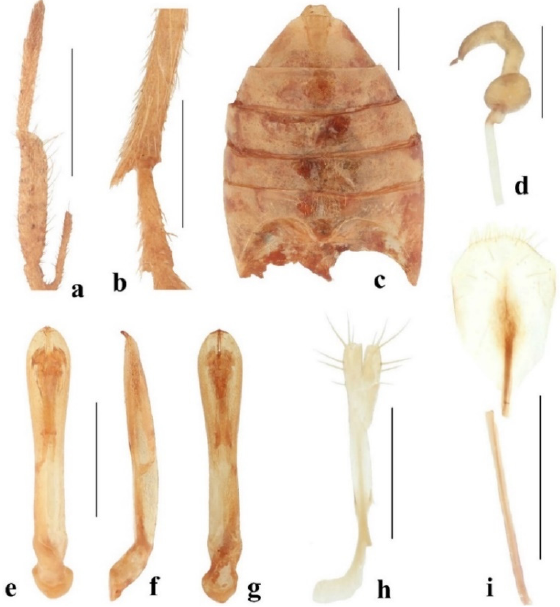
Figure 11. Taumacera unicolor (Jacoby, 1887): ( a ) antennomeres X–XII, dorsal view; ( b ) apex of metatibia and metatarsomere I, male; ( c ) male abdomen, ventral view; ( d ) spermatheca; ( e ) aedeagus, dorsal view; ( f ) aedeagus, lateral view; ( g ) aedeagus, ventral view; ( h ) gonocoxae; ( i ) sternite VIII. (Scale bars: ( a – c , e – g , i ) = 1 mm, ( d , h ) = 0.5 mm).